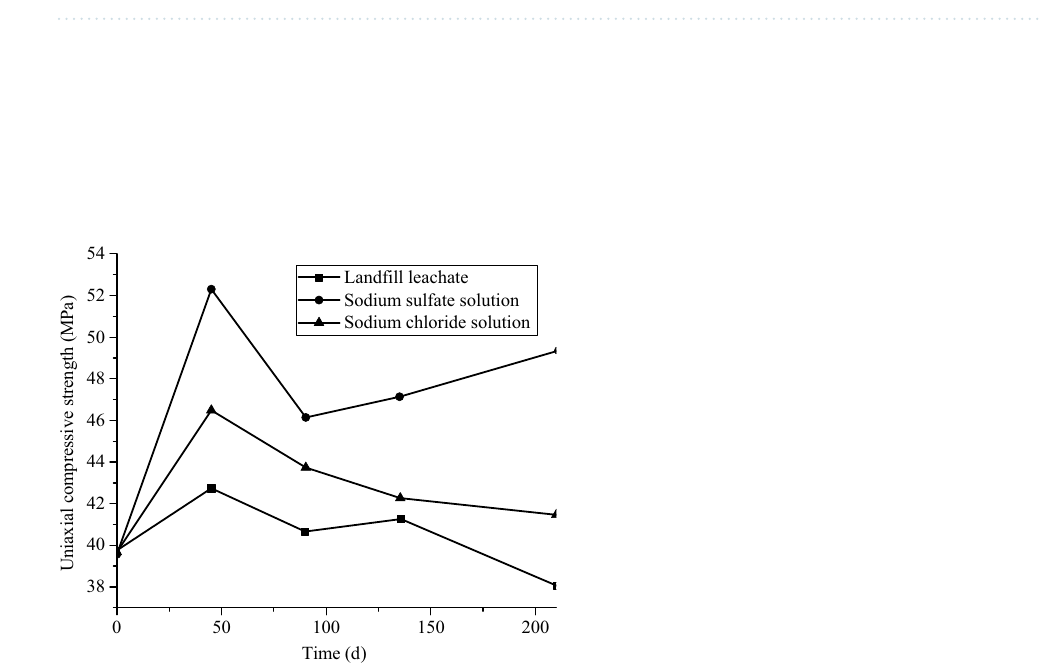
Figure 8. Modulus of elasticity at different aggressived depths for Group HLLN.